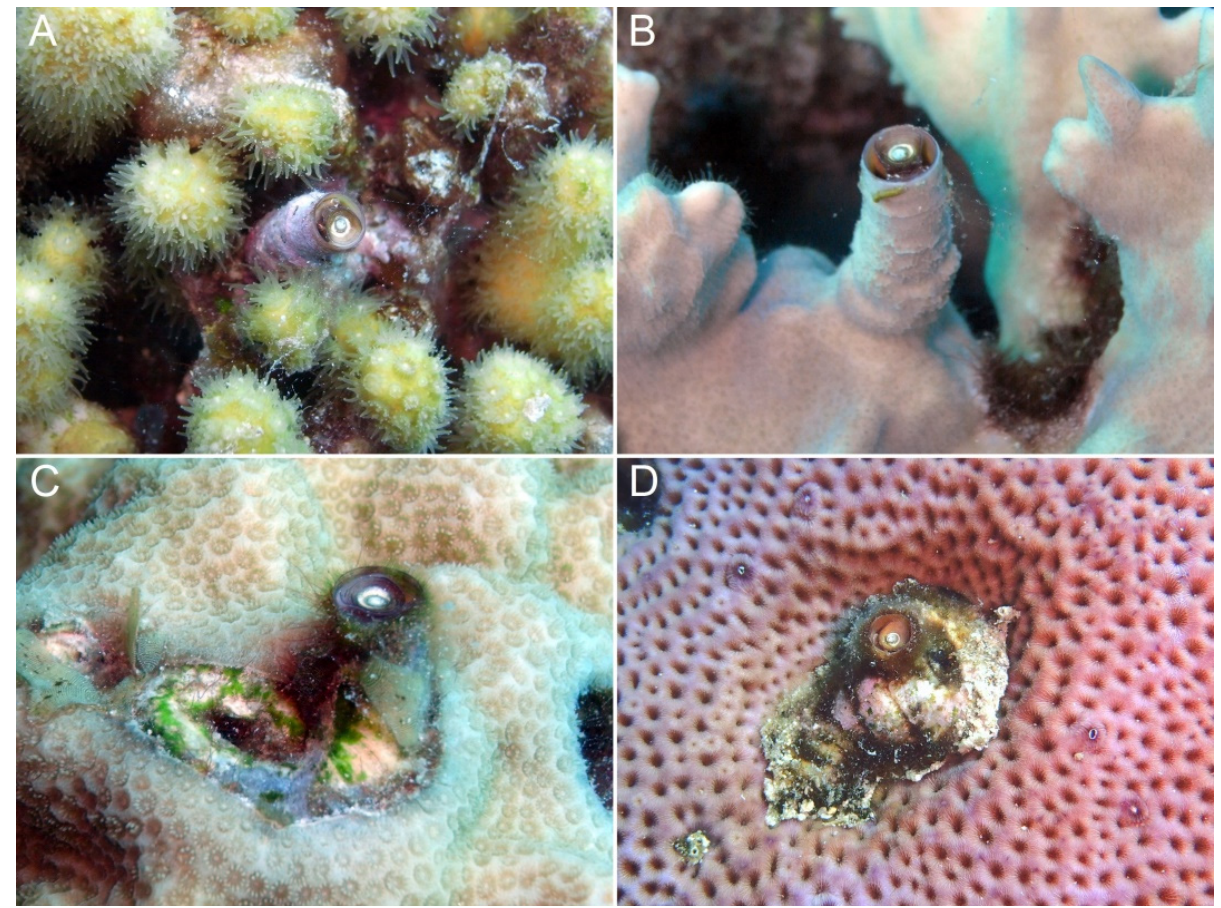
Figure 2. Worm snails ( Petaloconchus sp.) hosted by the branching corals Madracis auretenra ( A ) and Millepora alcicornis ( B ), and the massive corals Porites astreoides ( C ) and Siderastrea siderea ( D ). The snail tube in M. alcicornis is entirely over- grown by the coral ( B ), whereas the snails in both massive corals have caused considerable damage to their hosts ( C , D ). Tube diameter: ca. 4 mm.